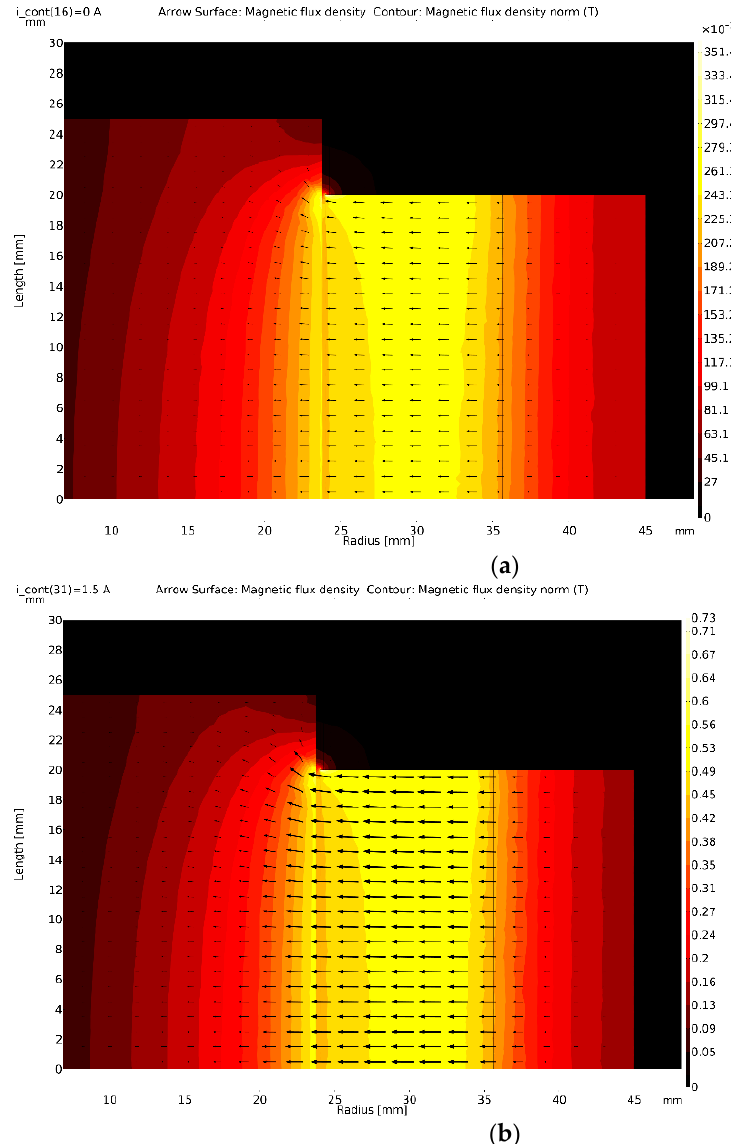
Figure 10. Magnetic flux density along the magnetic bearing for a control current of 0 A ( a ) and 1.5 A ( b ).